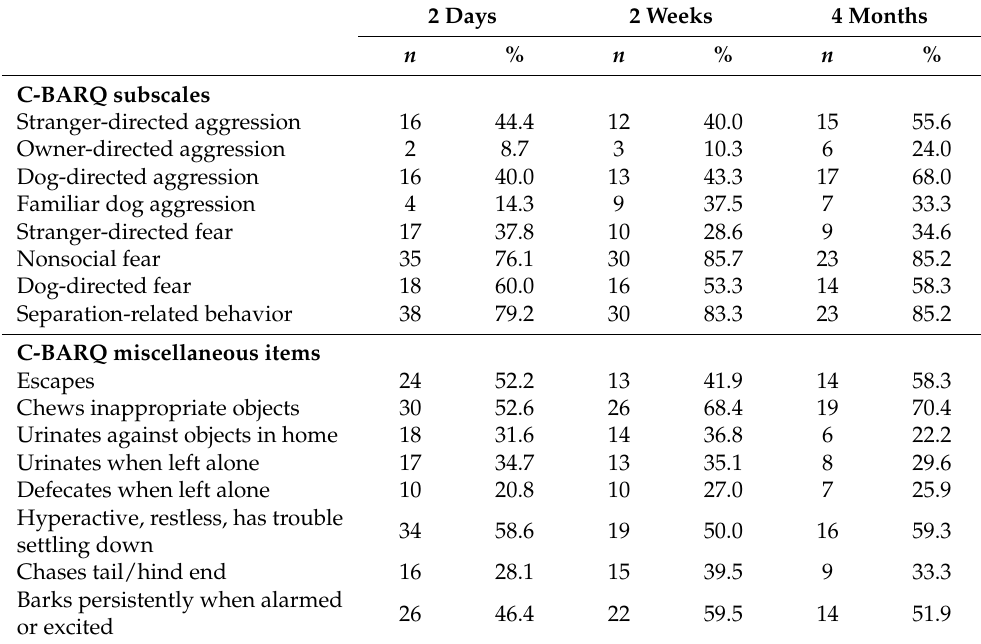
Table 4. Prevalence of undesirable behavior based on C-BARQ subscales and miscellaneous items.